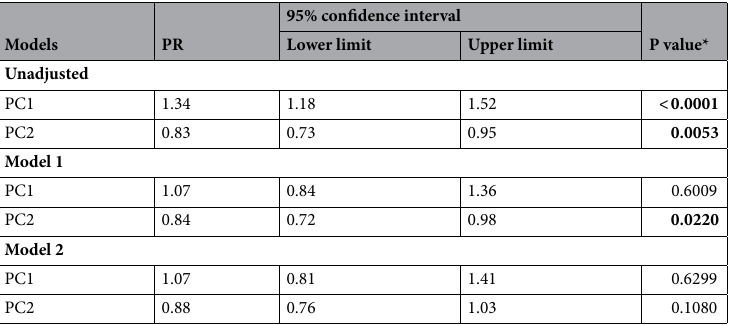
Table 2. Multivariable adjusted prevalence ratios (95% Confidence Intervals) for prevalent type 2 diabetes mellitus and principal component axes among adult females over 20 years of age using data from the Nituuchischaayihtitaau Aschii —Multi-Community Environment-and-Health Study (2005–2009). Part of this Table is reproduced from Zuk et al. 33 . PC1 and PC2, first and second orthogonal principal component axes, respectively; PR, prevalence ratio. *Significance (p-value < 0.05). Model 1: adjusted for age, lipids, BMI, smoking status, education; Model 2: Model 1 + parity. Significant values are in bold (p-value <